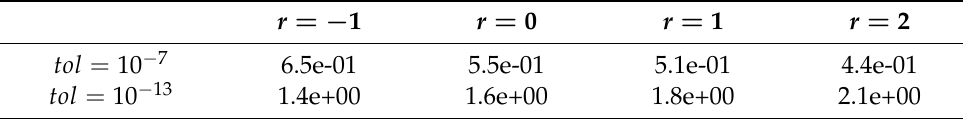
Table 1. CPU time to calculate (6) for the data in Section 2.1 with subroutine phipm.m. r = − 1 r = 0 r = 1 r = 2 tol = 10 − 7 6.5e-01 5.5e-01 5.1e-01 4.4e-01 tol = 10 − 13 1.4e+00 1.6e+00 1.8e+00